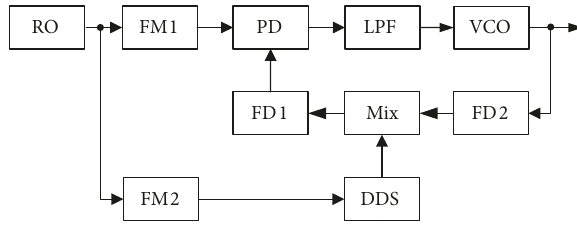
Figure 5: The block diagram of the hybrid frequency synthesizer with DDS as a support oscillator of the PLL.